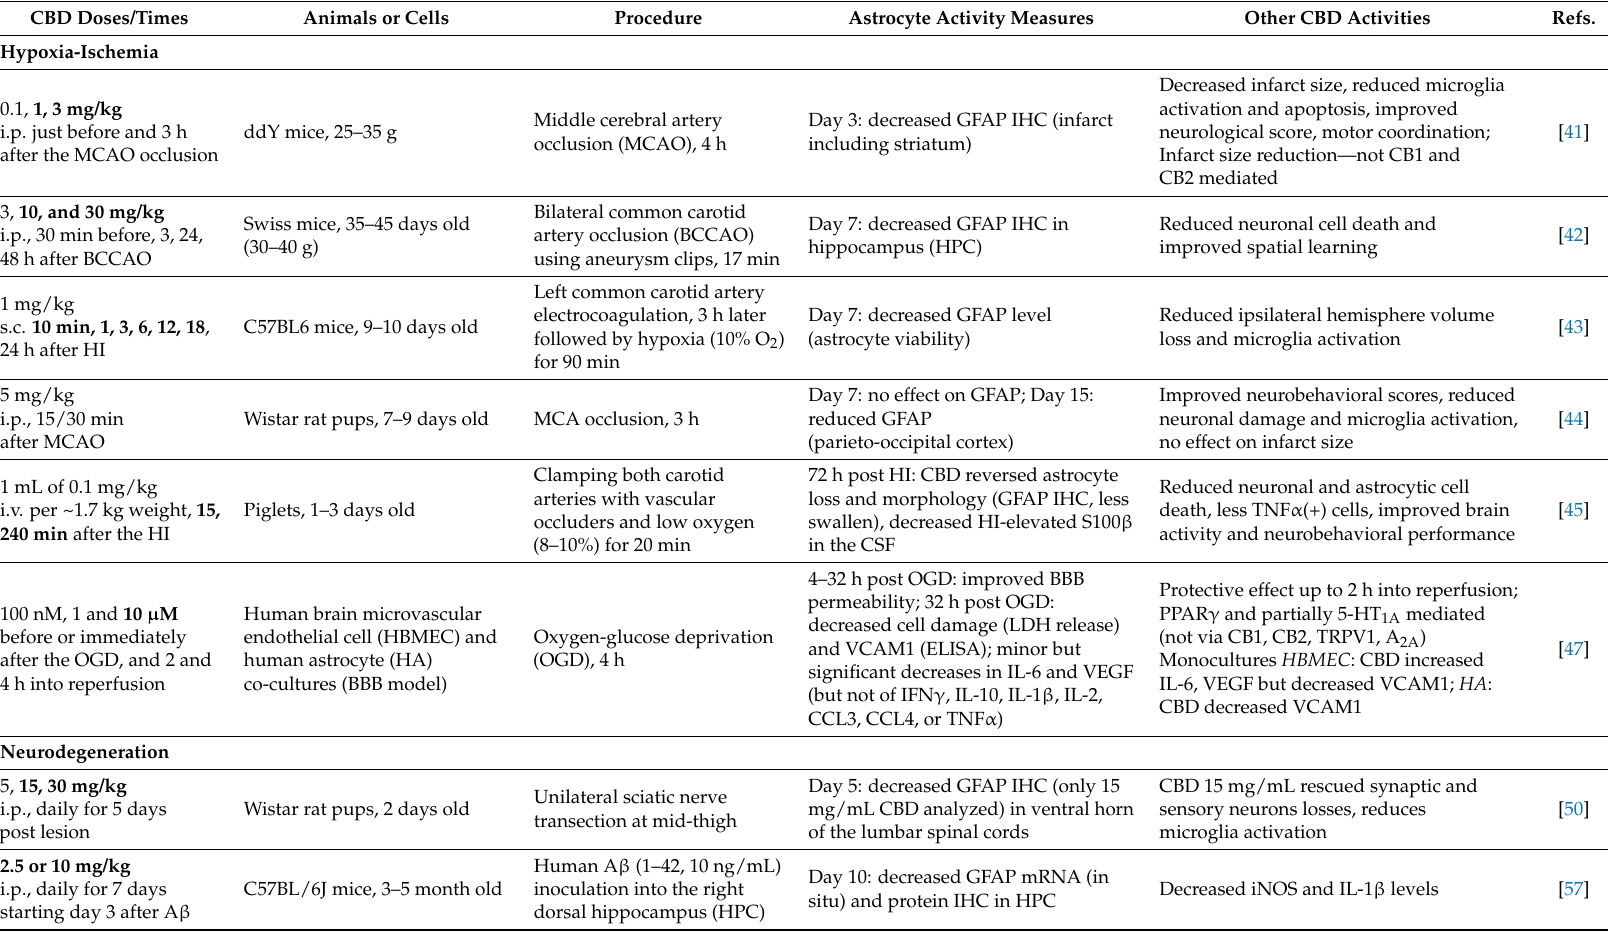
Table 1. CBD (Cannabidiol) modulation of astrocyte activity in neuropathological models. If multiple doses/time points of CBD application are presented, the effective doses/time points are